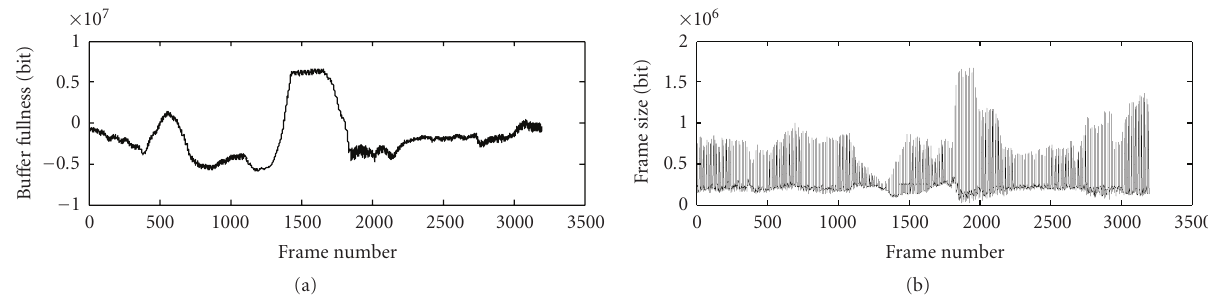
Figure 8: Bu ff er occupancy and frame size of “The Living Sea” video sequence encoded with FFMPEG VBR video rate controller.